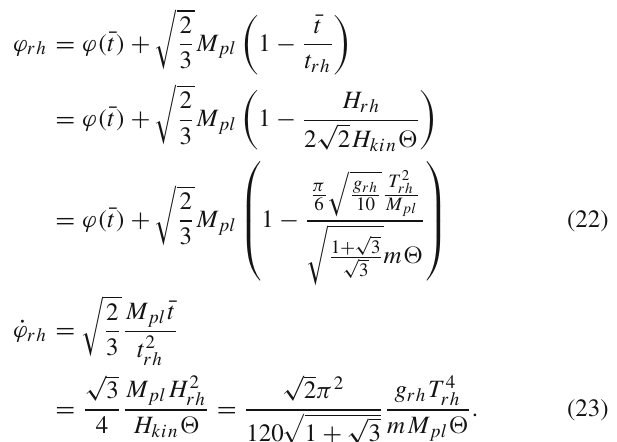
Calculation of the heat efficiency (cid:15) : The energy density of theproducedmassiveparticleswithmass m χ = 5 × 10 − 4 M